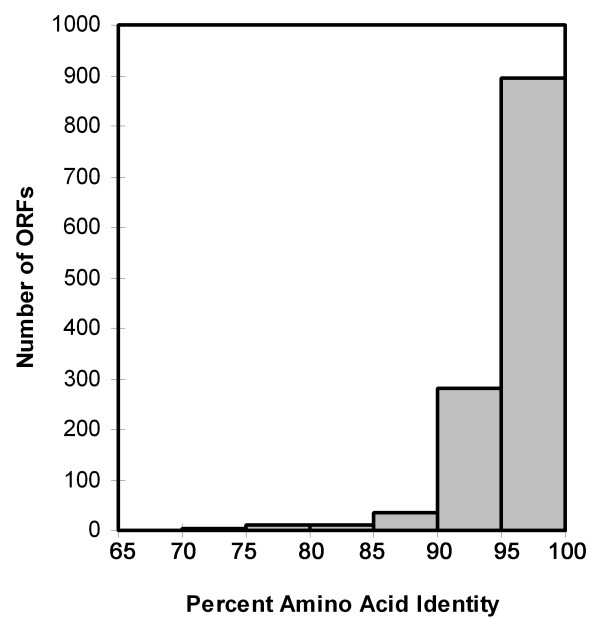
Relatedness of core proteins predicted to be encoded by H. pylori strains 98-10 and 26695. A set of 1237 genes present in all 5 H. pylori strains was identified, as described in the Methods. The deduced amino acid sequences of the corresponding proteins encoded by strain 98-10 were used to search a database of sequences from strain 26695 using FastA. The best match was identified, and the percent amino acid identity was calculated. The histogram shows the number of ORFs exhibiting the indicated level of amino acid identity.